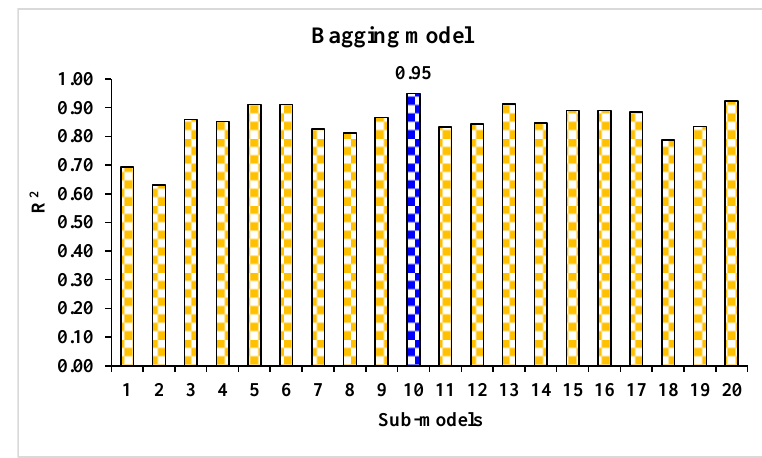
Figure 22. Determination coefficient (R 2 ) values for sub-models. ( a ) Random forest; ( b ) AdaBoost; ( c ) Bagging